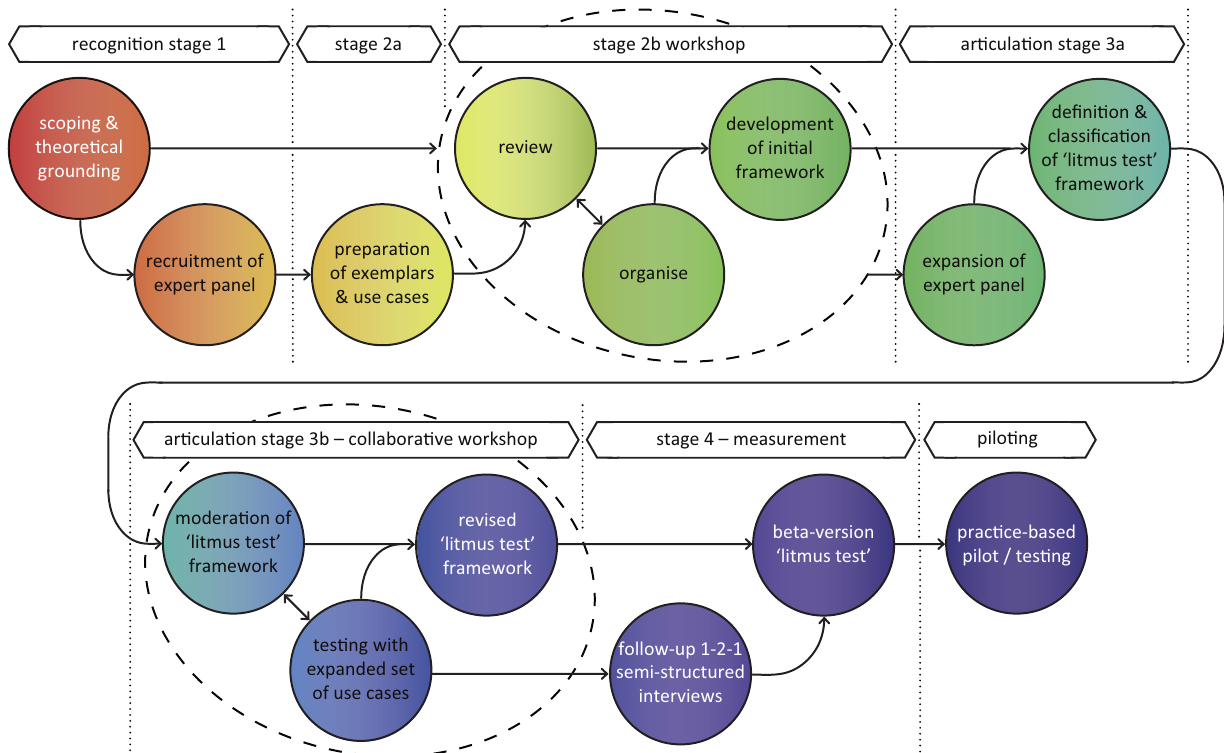
Figure 2. Summary of research methodology in the development of the “litmus